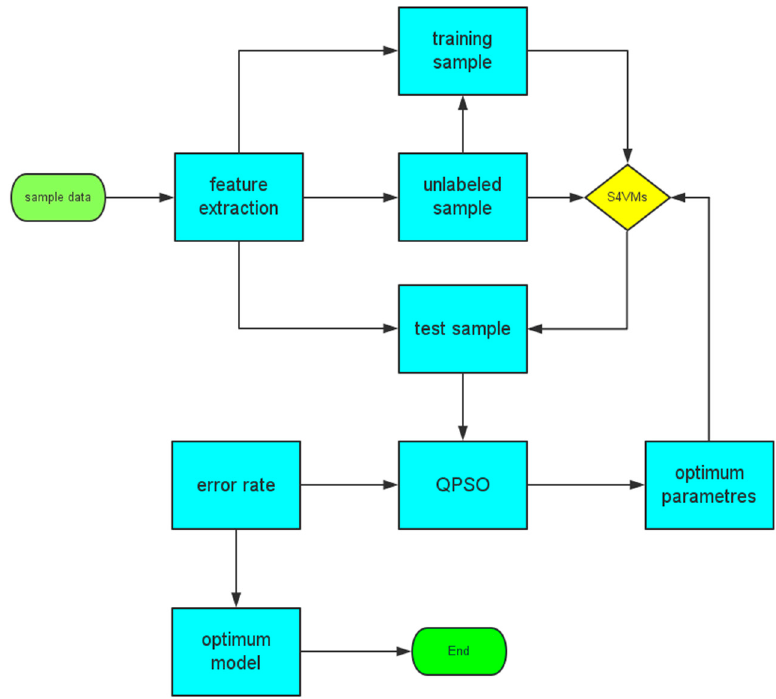
Figure 8. Flow chart of the algorithm.